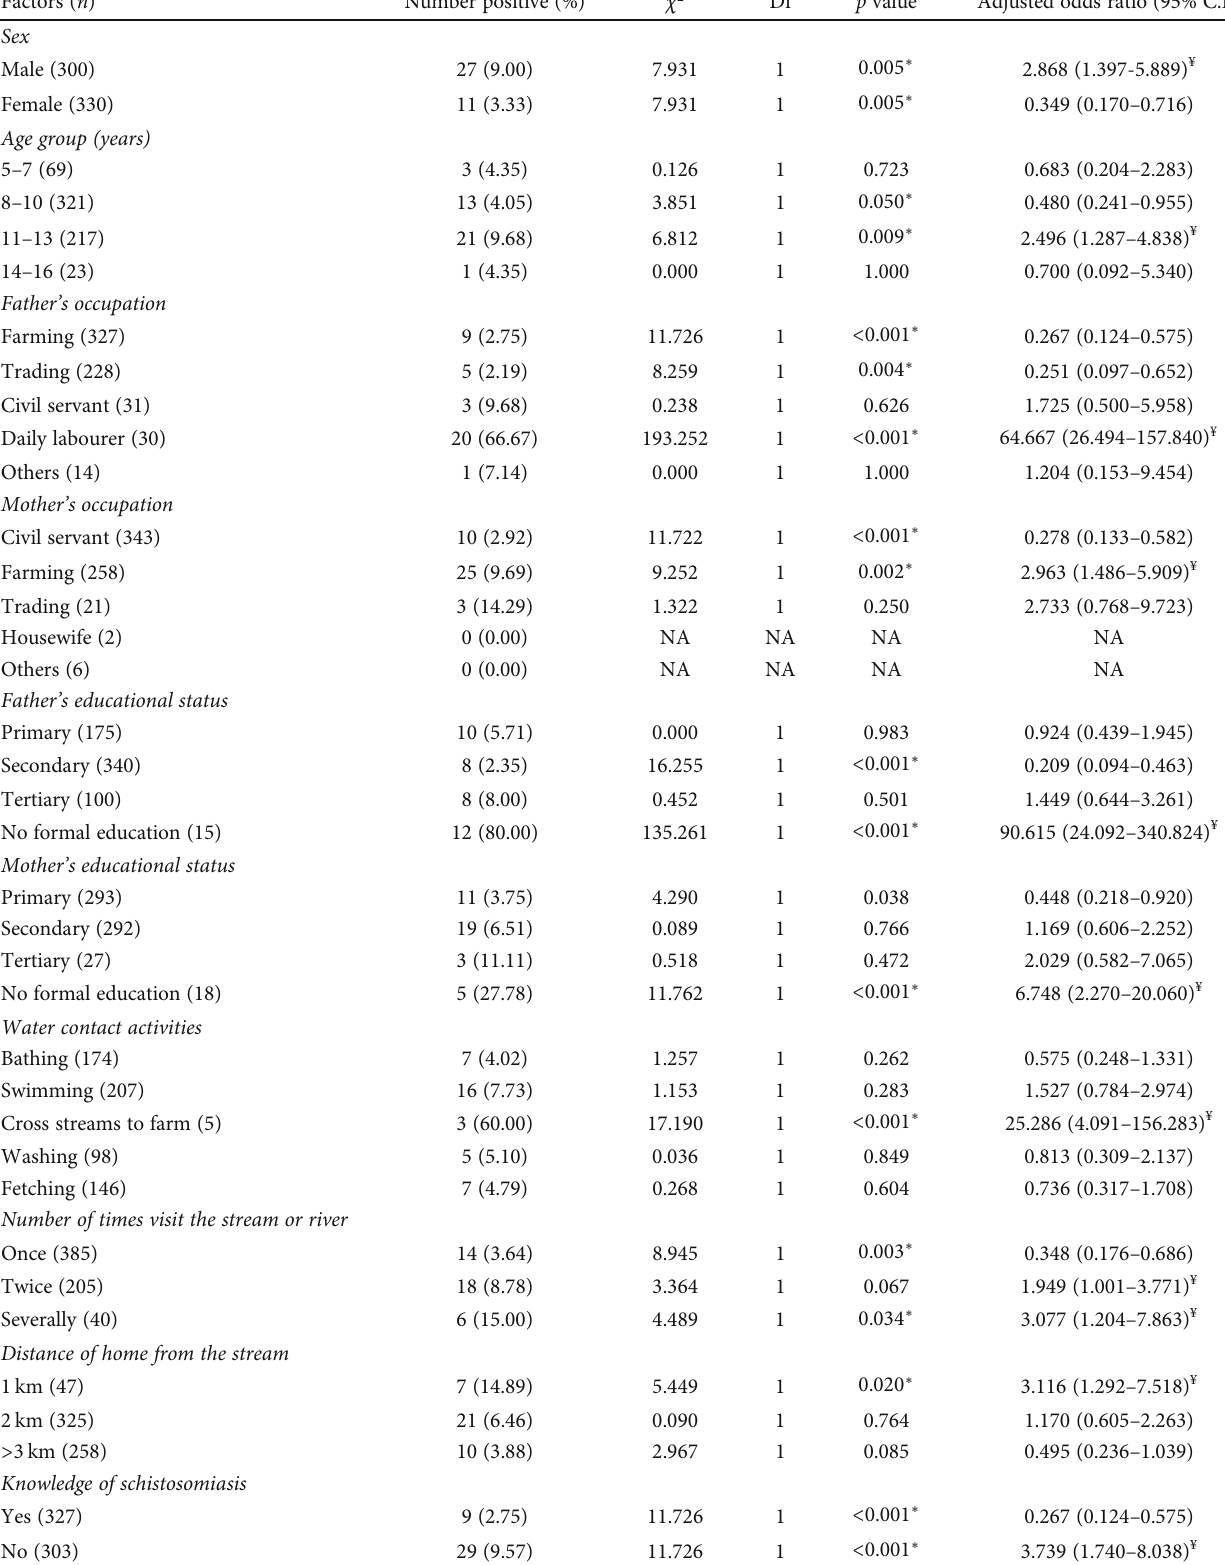
Table 5: Bivariate and multivariate analysis of risk factors associated with urogenital schistosomiasis among school children in Biase